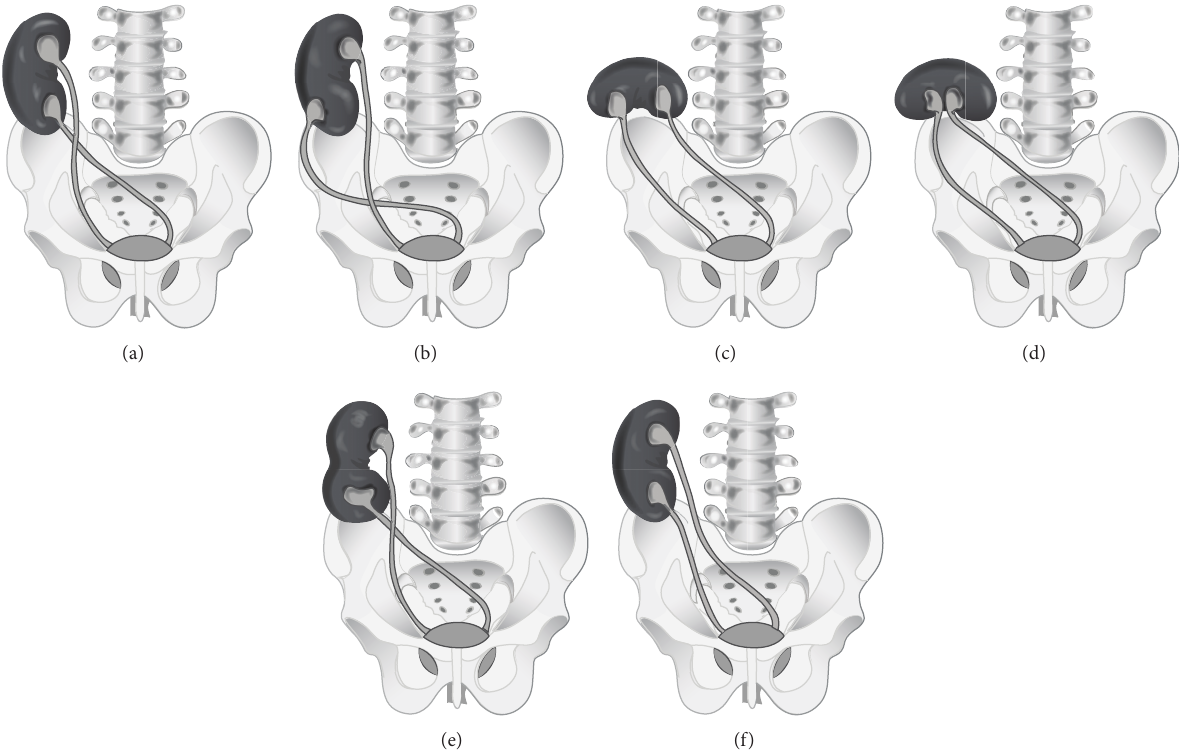
Figure 2: Six anatomical variations (types) of crossed fused renal ectopia: (a) inferior crossed fused renal ectopia; (b) sigmoid or S-shaped kidney; (c) lump kidney; (d) disc kidney; (e) L-shaped kidney; (f) superior crossed fused renal